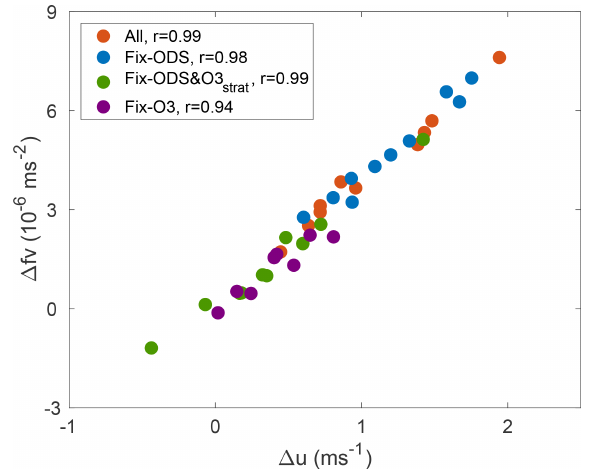
Figure 7. The response over the second half of the 20th century forcing of the DJF lower troposphere midlatitude to high-latitude Coriolis force on the meridional flow ( (cid:49)f v ) as a function of the mean zonal wind ( (cid:49)u ) in the full forcing ensemble (All, red), fixed ODS ensemble (Fix-ODS, blue), fixed ODS and stratospheric ozone ensemble (Fix-ODS&O3 strat , green), and fixed stratospheric and tropospheric ozone ensemble (Fix-O3, purple). Correlations appear in the upper left